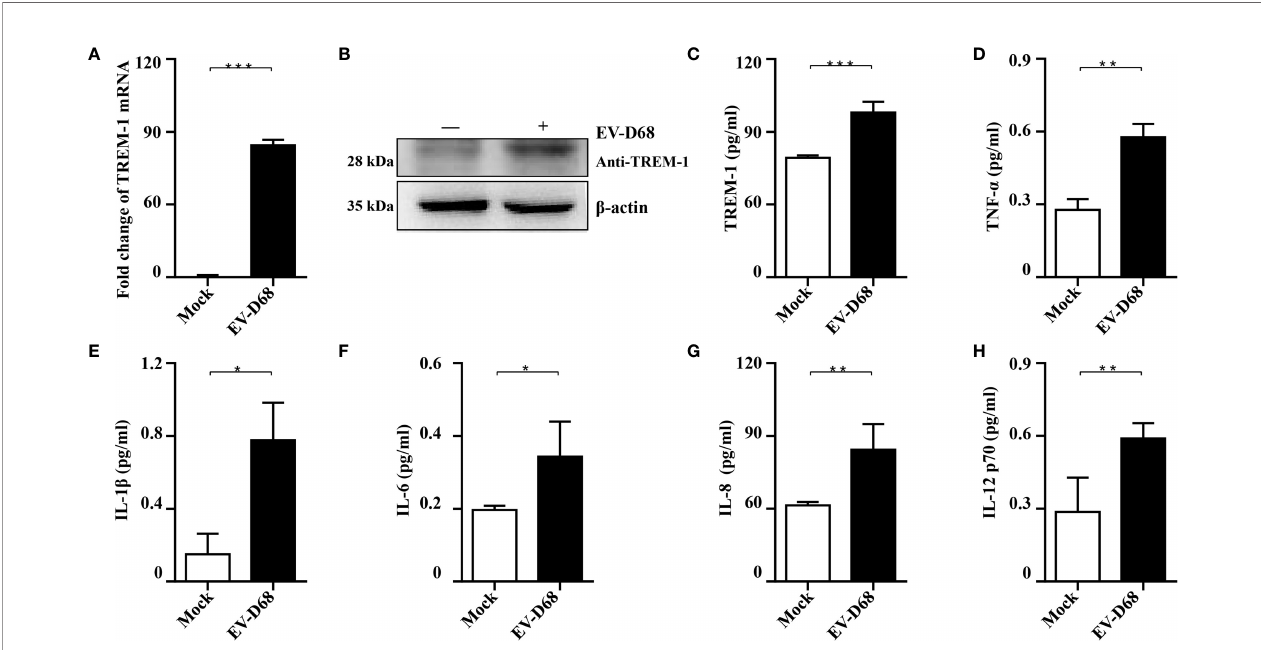
FIGURE 3 | Validation of RNA-seq data. ( A-C ) EV-D68 infection upregulates TREM-1 mRNA and protein abundance in RD cells. EV-D68-infected RD cells were collected at 24 hpi (MOI = 0.1), and TREM-1 mRNA levels were measured by RT-PCR (A) . The GAPDH gene served as an internal control, and relative gene expression (fold change) levels of each gene were calculated using the comparative 2 - DD CT method. Values are mean ± standard deviation (SD). TREM-1 protein levels were measured by WB (B) and ELISA (C) . (D-H) EV-D68 infection upregulates TREM-1 downstream in fl ammatory cytokine production. MILLIPLEX assays were used to measure the expression levels of cytokines TNF- a (D) , IL-1 b (E) , IL-6 (F) , IL-8 (G) , and IL-12 p70 (H) . * p < 0.05, ** p < 0.01, *** p <